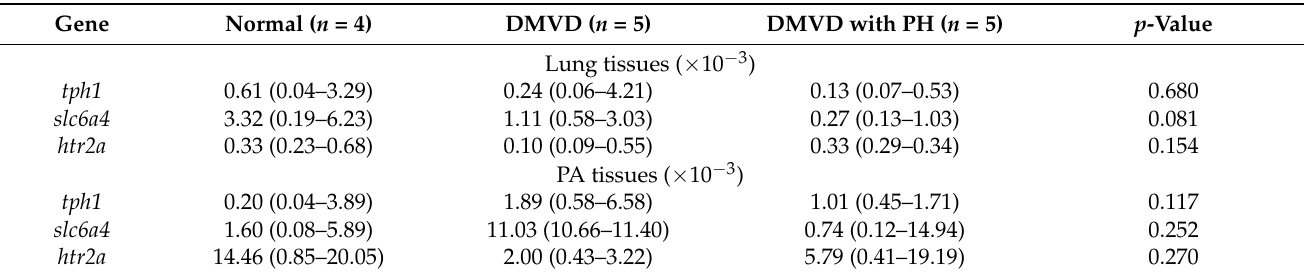
Table 4. The relative expression of the targeted